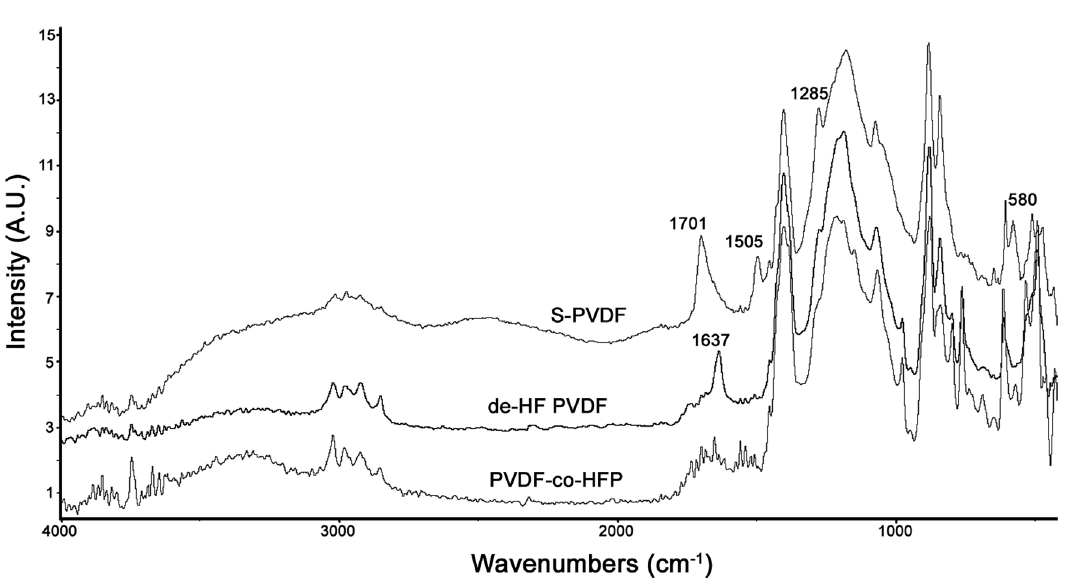
Figure 4. Photoacoustic FTIR spectra comparison between PVDF-co-HFP, dehydrofluorinated PVDF-co-HFP, and